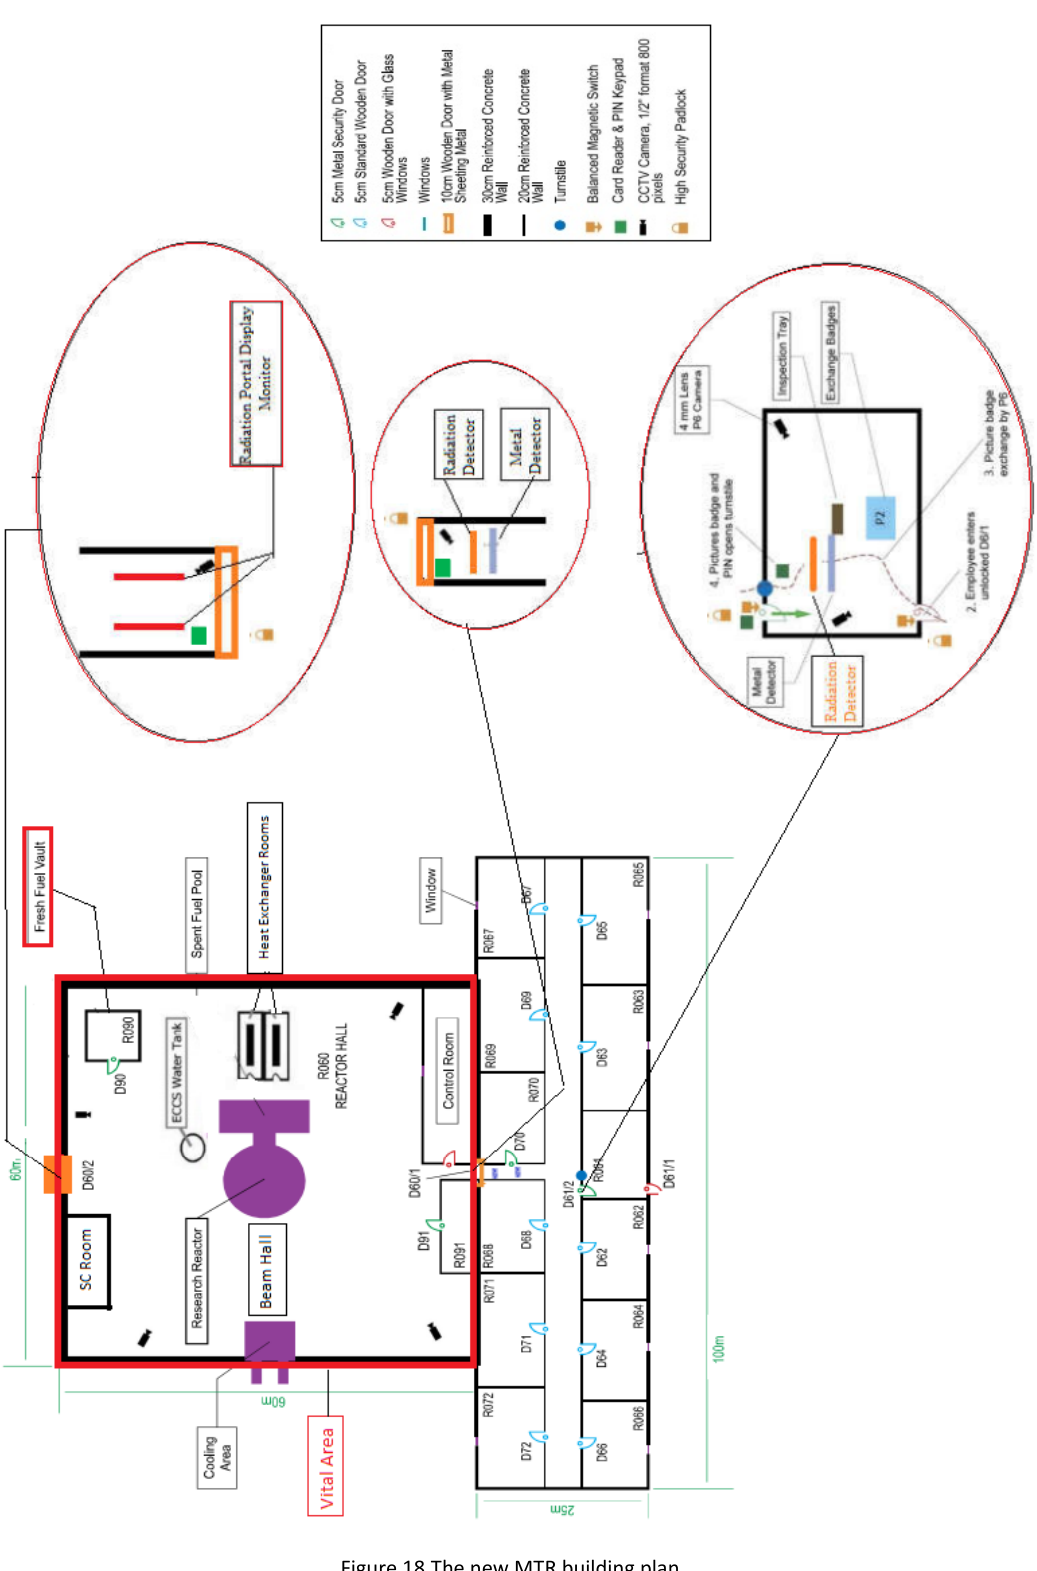
Figure 18.The new MTR building